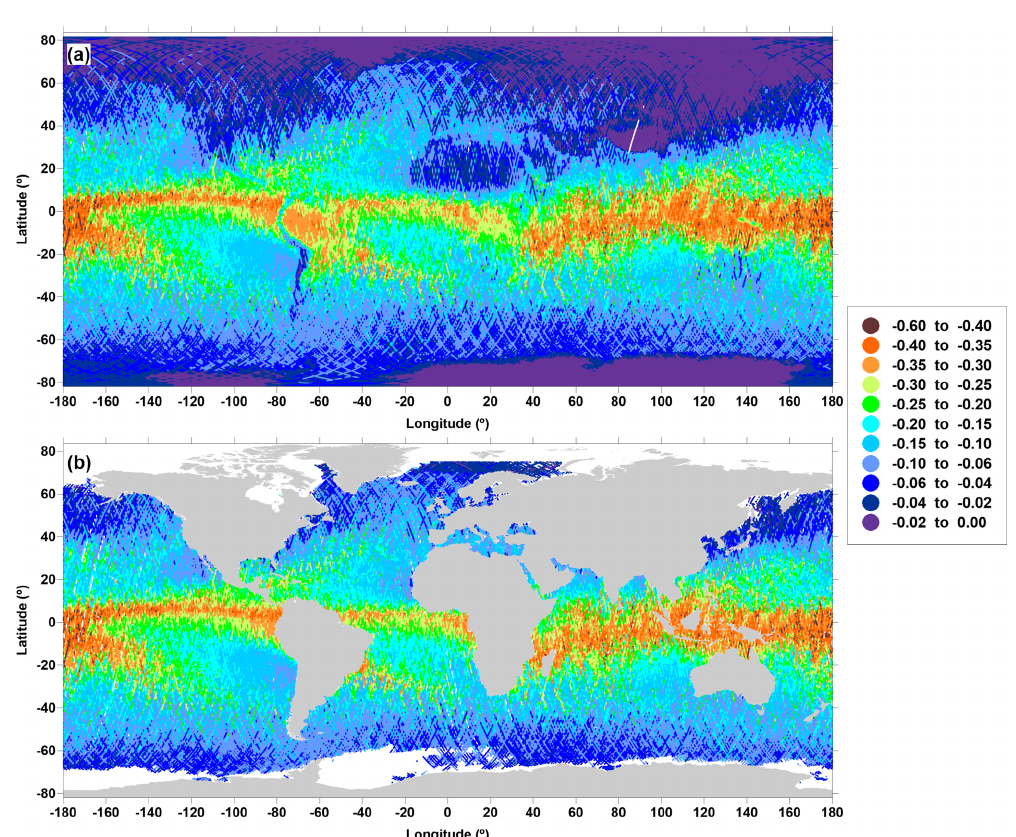
Figure 6. GPD + WTC, in metres, for Envisat cycle 12: (a) global coverage and (b) correction over oceanic regions with valid SLAs.